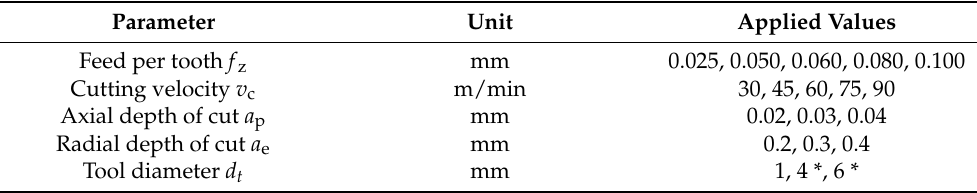
Table 1. Evaluated parameter values of the micro-milling process. Parameter Unit Applied Values Feed per tooth f z mm 0.025, 0.050, 0.060, 0.080, 0.100 Cutting velocity v c m/min 30, 45, 60, 75, 90 Axial depth of cut a p mm 0.02, 0.03, 0.04 Radial depth of cut a e mm 0.2, 0.3, 0.4 Tool diameter d t mm 1, 4 *, 6